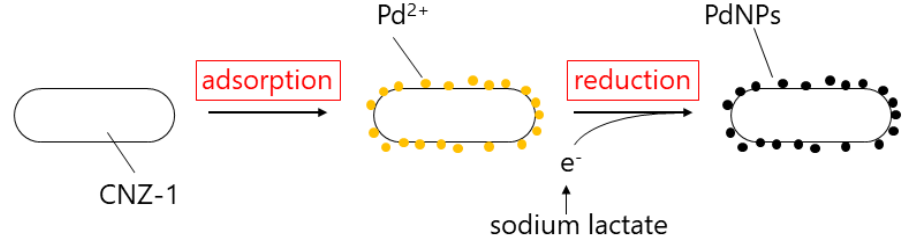
Figure 8. The mechanism of Pd NPs synthesis by Shewanella sp. CNZ-1. At first, the bacteria adsorbed Pd ion. The Pd ion were reduced by electron from added sodium lactate.